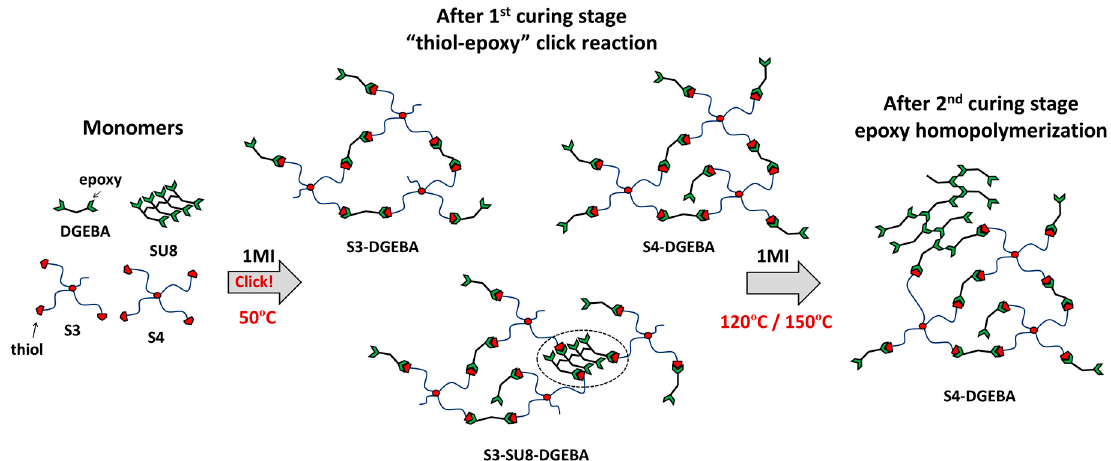
Figure 5. Monomers and expected network structures after the first and second curing stages for all the systems of study.